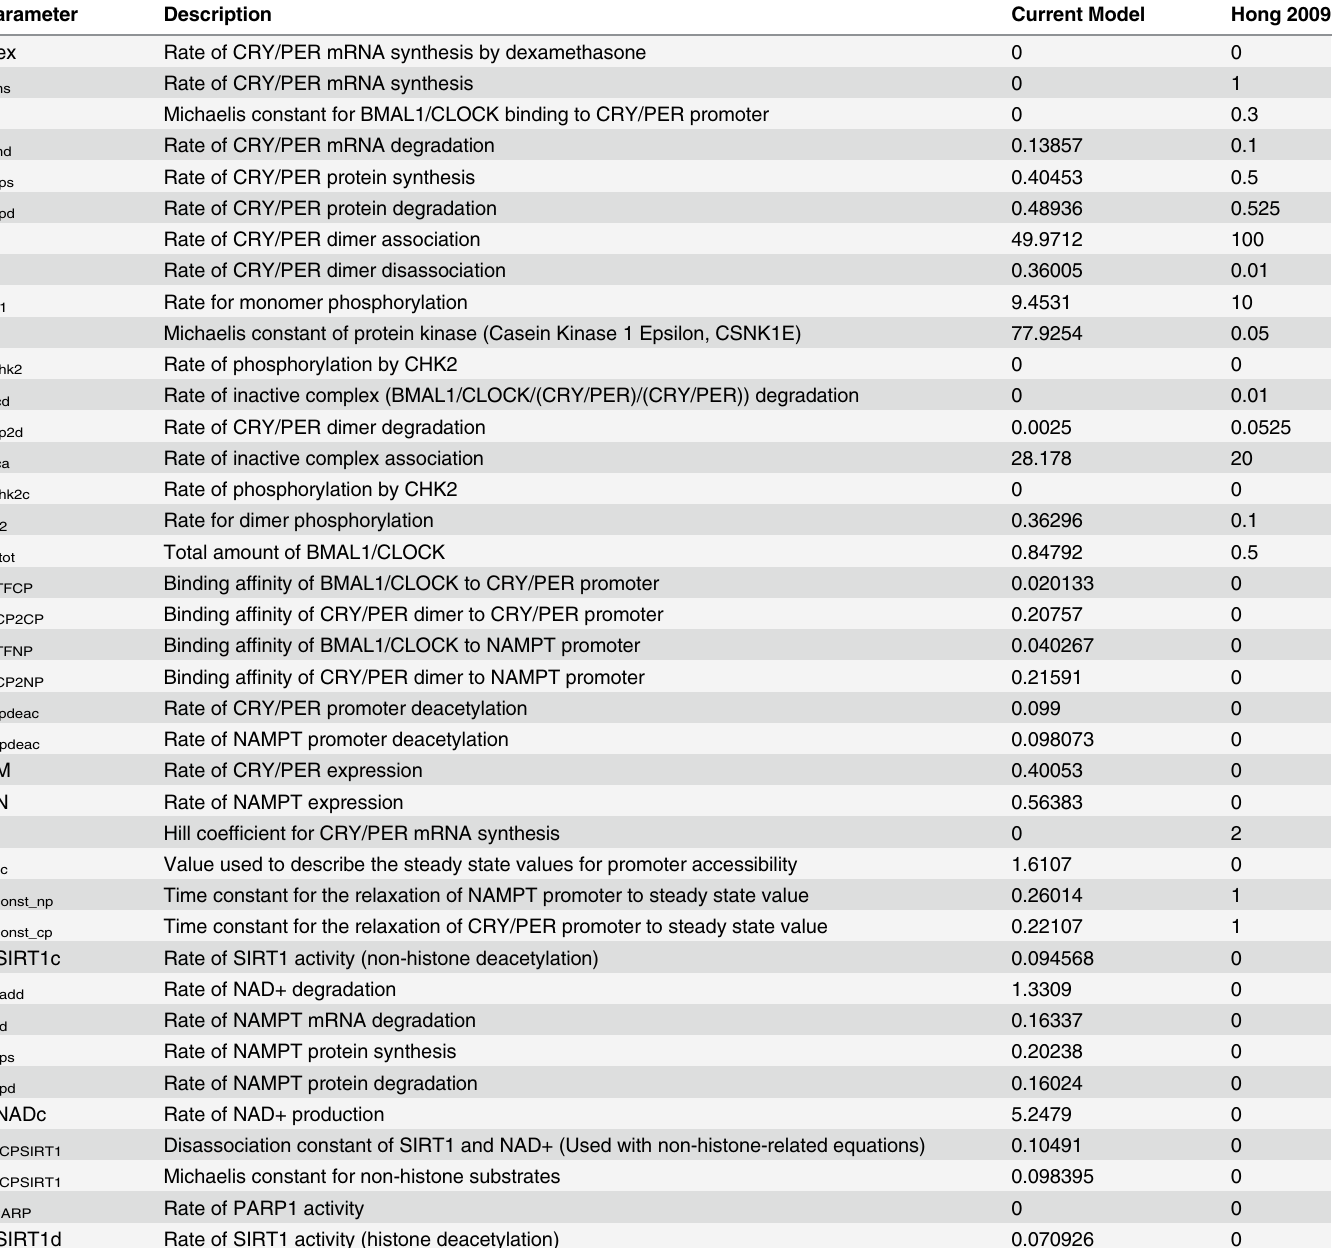
Table 2. Parameter values for current and Hong 2009